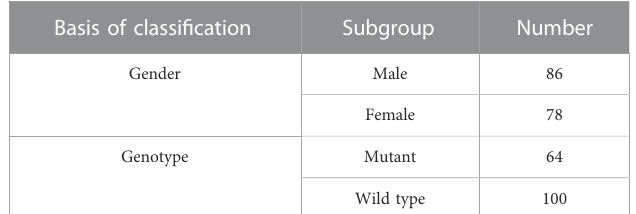
TABLE 1 Basic information about the test